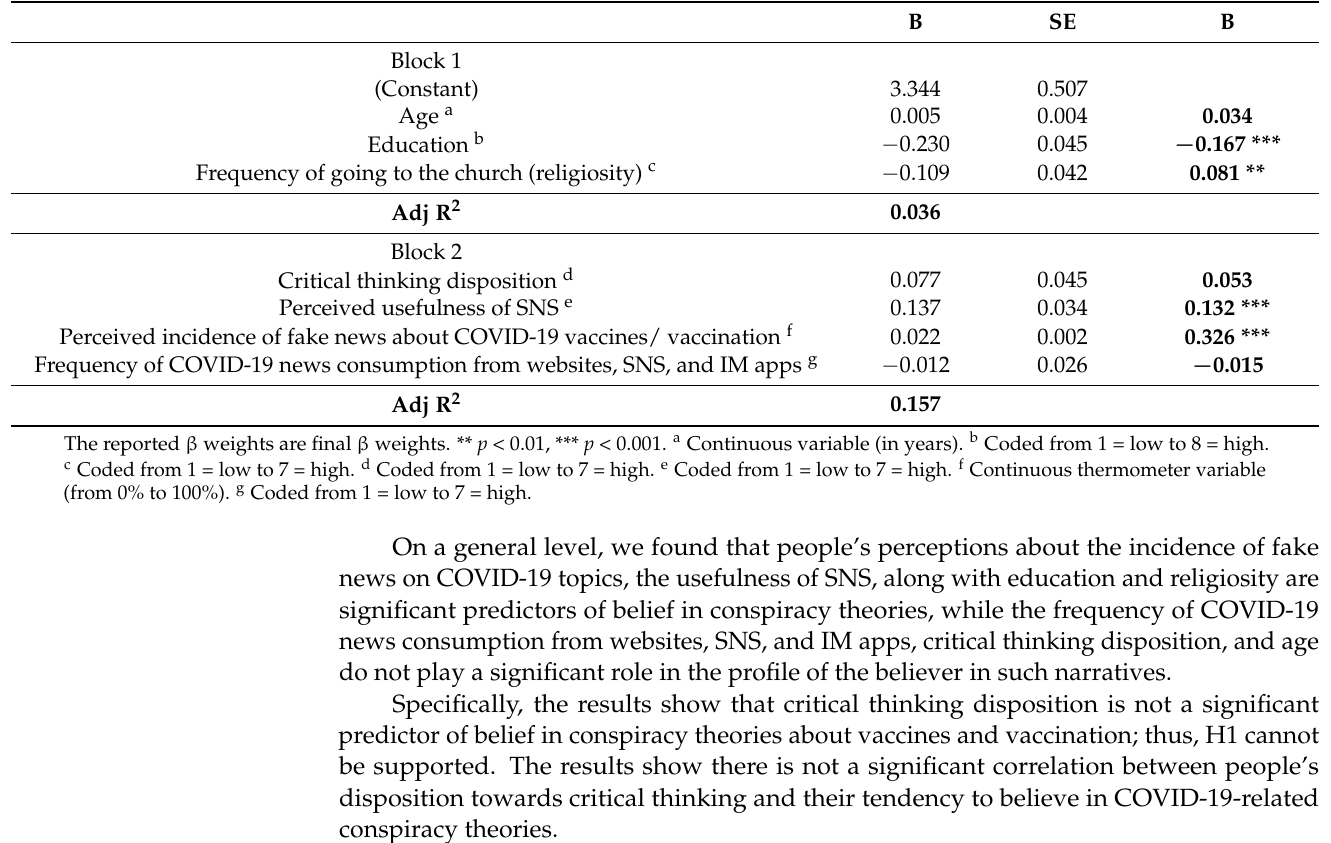
Table 1. OLS regression model predicting belief in conspiracy theories about COVID-19 vaccines.